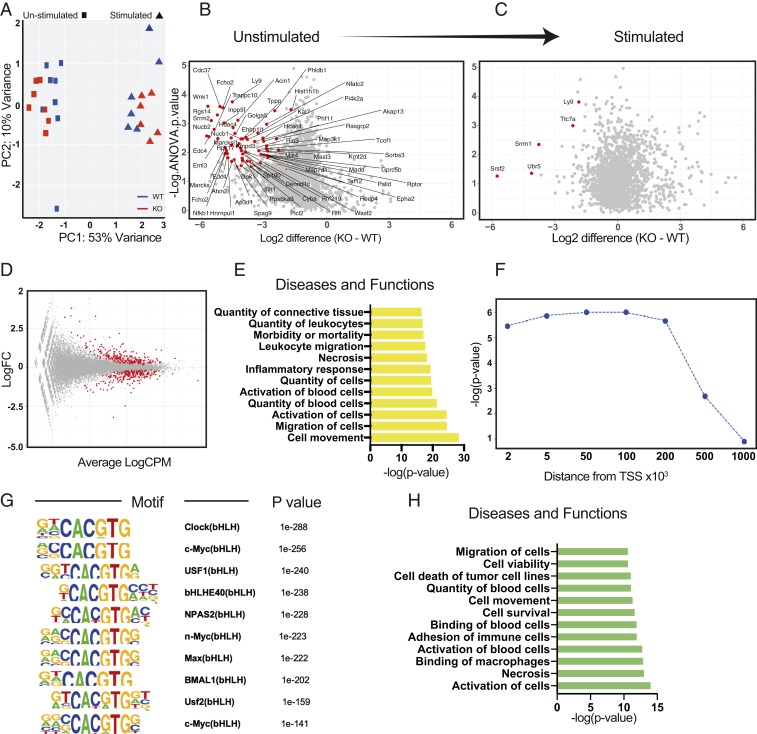
BMAL1 deletion in macrophages preactivates the cells. (A) Phagocytosis gene array in peritoneal macrophages using NanoString technology. Peritoneal macrophages were purified from LysM-Bmal1−/− and floxed littermate controls mice, and cultured in vitro for 24 h, and then 100 µg/mL S. aureus or control media was added for 1 h. RNA was purified and analyzed by NanoString, using a phagocytosis panel (SI Appendix, Table S1). The principal component analysis (PCA) plot comparing stimulated and control cells from both of the two genotypes is shown, with the LysM-Bmal1−/− (red) and floxed littermate controls (blue). Each point represents an individual mouse. (B and C) Peritoneal macrophages from LysM-Bmal−/− and floxed littermate controls harvested at ZT2 were cultured for 24 h and then treated with 100 µg/mL S. aureus for 30 min (stimulated) or vehicle control (unstimulated). Cells were harvested and phosphopeptides purified. On the volcano plots, significant changes in identified phosphorylation sites are shown in red. Negative x axis values indicate lower in BMAL1−/− cells (identified by ANOVA with post hoc test; n = 3). (D) RNA-Seq in unstimulated peritoneal macrophages. Magnitude-Average (MA) plot showing 454 genes with false discovery rate (FDR) < 0.01, in red. Cpm, counts per million. (E) Top IPA diseases and functions terms for the significant DE genes in D. (F) Enrichment of RNA-Seq DE genes in relation to BMAL1 binding sites for different genomic distances from the center of the BMAL1 binding peaks. (G) Top 10 motifs found using the BMAL1 peaks overlapping with DE genes at ±100-kb distance. (H) Top IPA diseases and functions terms for the 148 BMAL1 direct target genes.